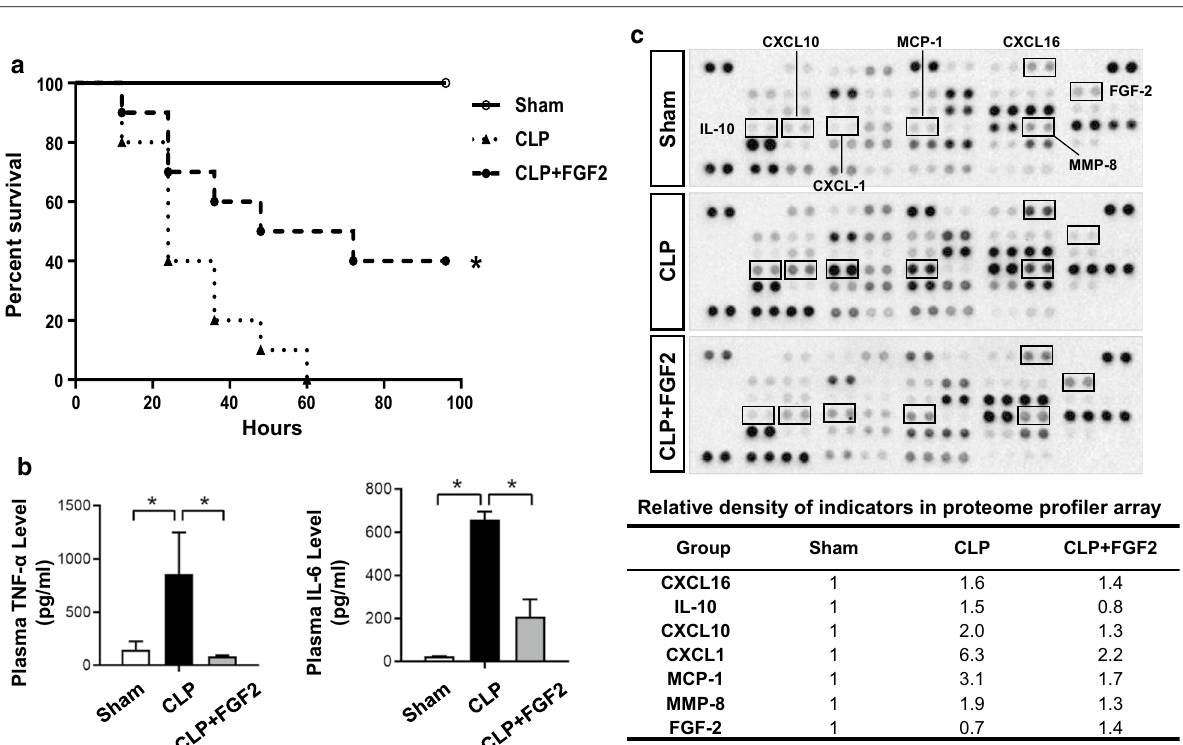
Fig. 1 FGF2 relieves the inflammatory response and improves survival in CLP-induced sepsis. a The survival rate for the experimental mice. The 8–10 weeks old C57BL/6 mice were subjected to CLP, intraperitoneal injected FGF2 (0.1 mg/kg) after 6 h, and prepared as sham group as well (n 10/group; Kaplan–Meier survival analysis). b The plasma levels of TNF-α and IL-6 were measured by ELISA kits at 24 h after CLP (n = c Plasma analyzed by angiogenesis antibody proteome profiler array and some indexes changed obviously were quantitatively analyzed. *P <